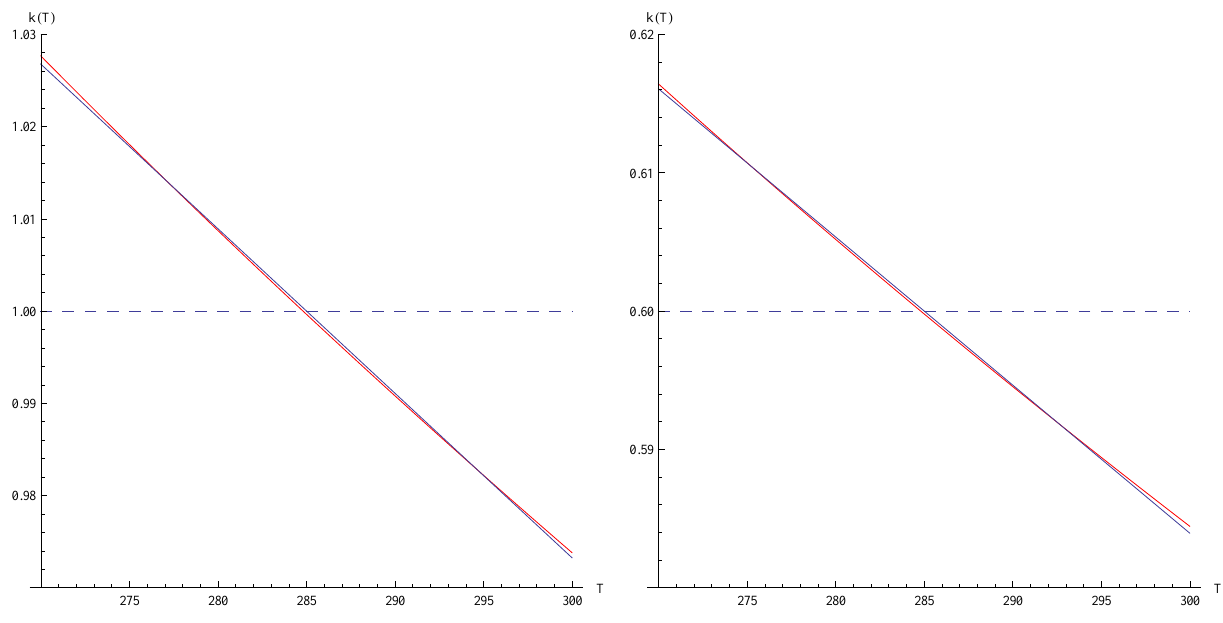
( T ) (red) compared with the best straight line Figure 6. Optimal monotonic functions k min k ( T, ξ ) (blue) from Figure 2 plotted with the optimal parameter ξ opt = 1 ; right: k = 0 . 6 . Please note the scaling of the Figure 1. left: k o o